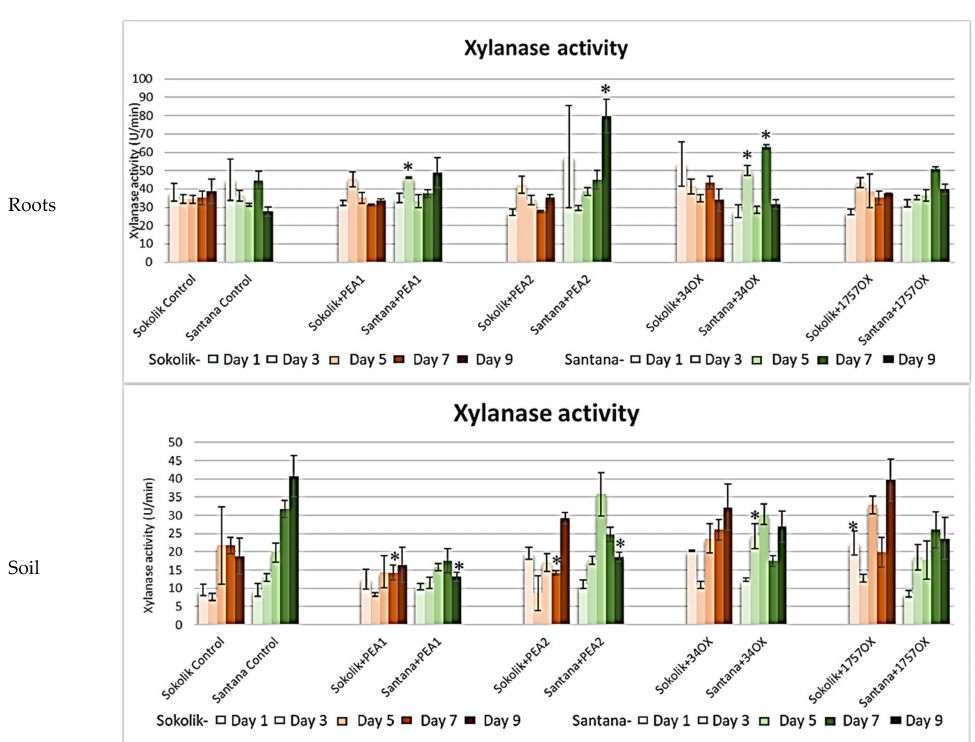
Figure 6. Xylanase activity (micromoles of xylose produced per minute (U/min)) obtained from the roots and soil of Sokolik and Santana infected with PEA1, PEA2, 34OX and 1757OX and the control (calculated from triplicate treatments). Error bar represents the standard error. * Statistically significant ( p < 0.05).